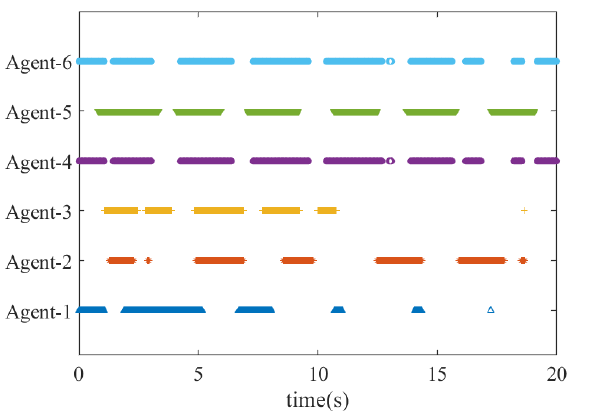
Figure 6. The state of triggered events of broadcasting signals under G 1 .